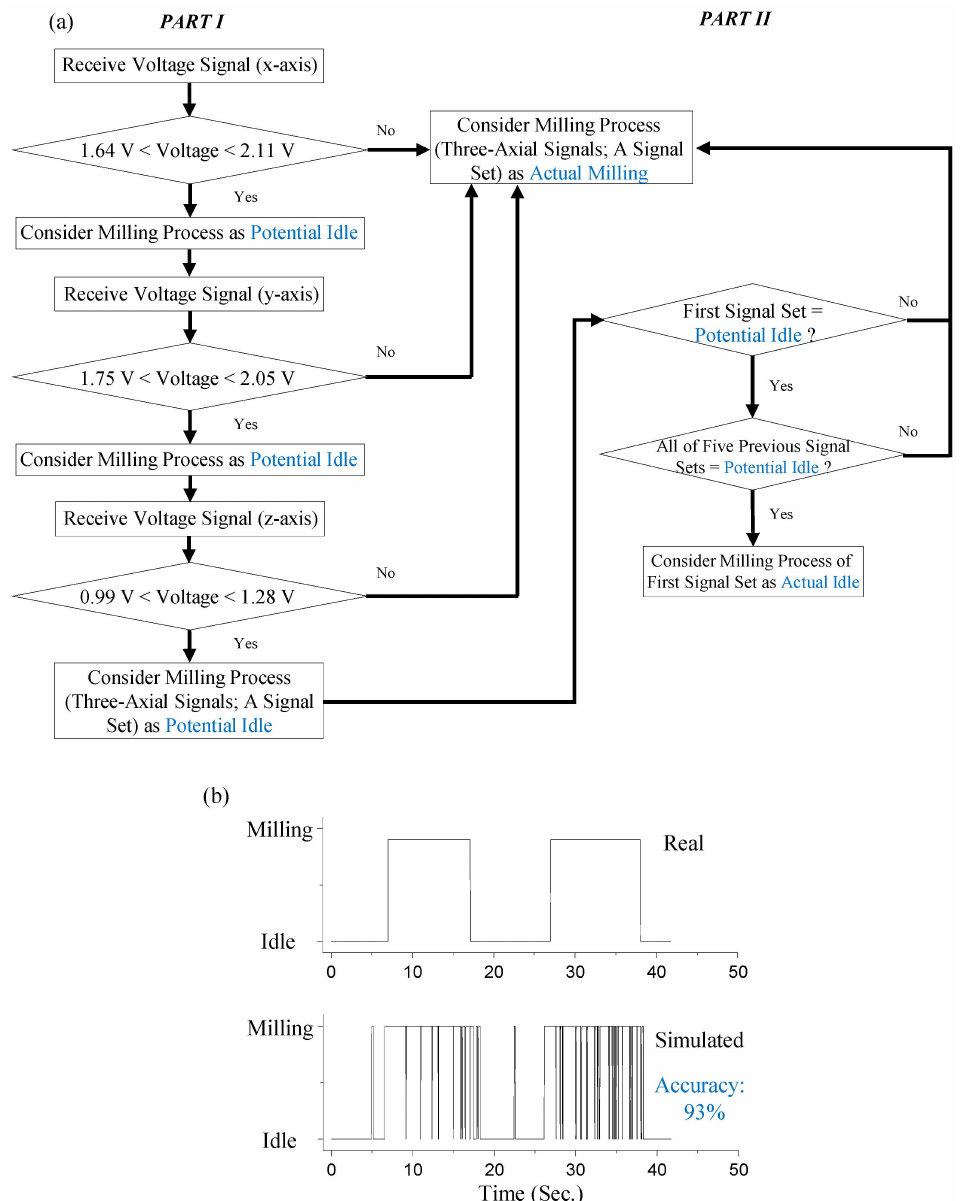
Figure 7. Using criterion for simulating milling status/sequence and corresponding results: ( a ) flow chart of the criterion, ( b ) comparing simulated status/sequence to real